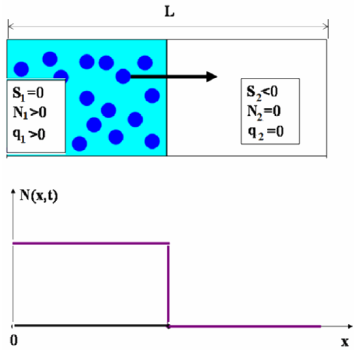
Figure 1. The schematic illustration of the 1-D mixing problem considered in the study. The initial state at t = 0 is illustrated. The left volume of length L/ 2 is a saturated cloudy volume; the right volume is a non-saturated air volume from the cloud